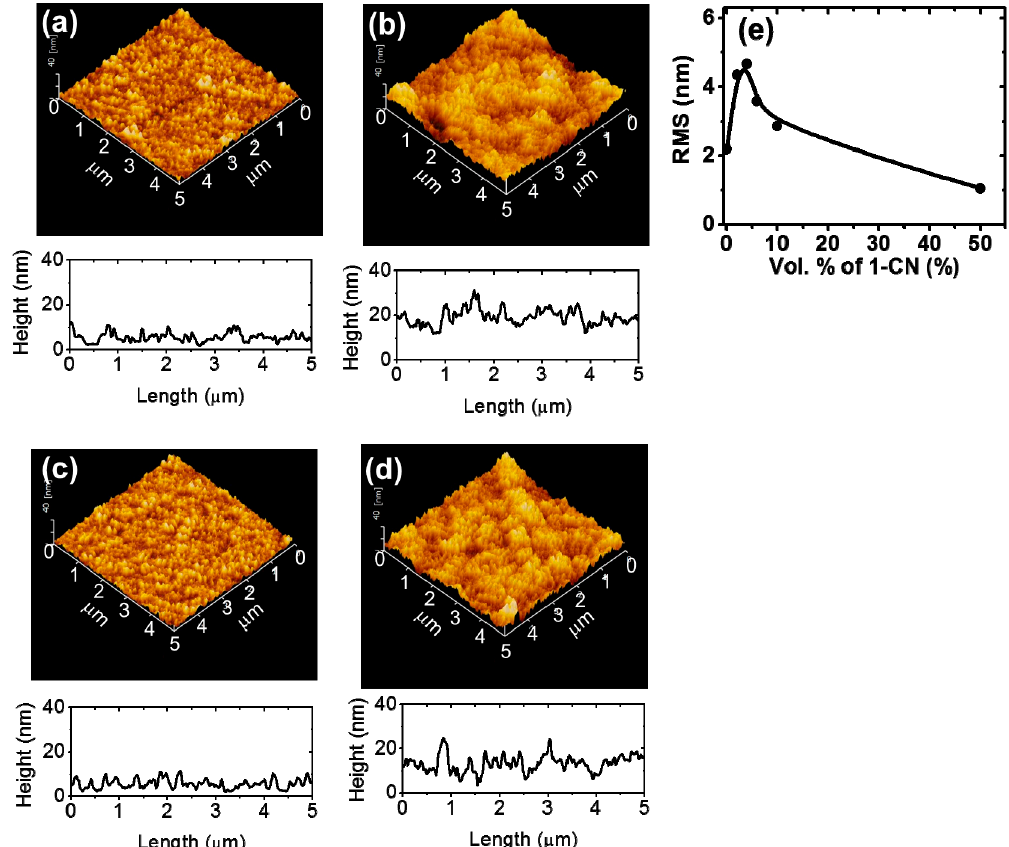
Figure 1. Surface morphologies and height profiles of the as prepared P3HT bottom-layer and the P3HT bottom-layer after removal of the PC61BM from the P3HT/PC61BM